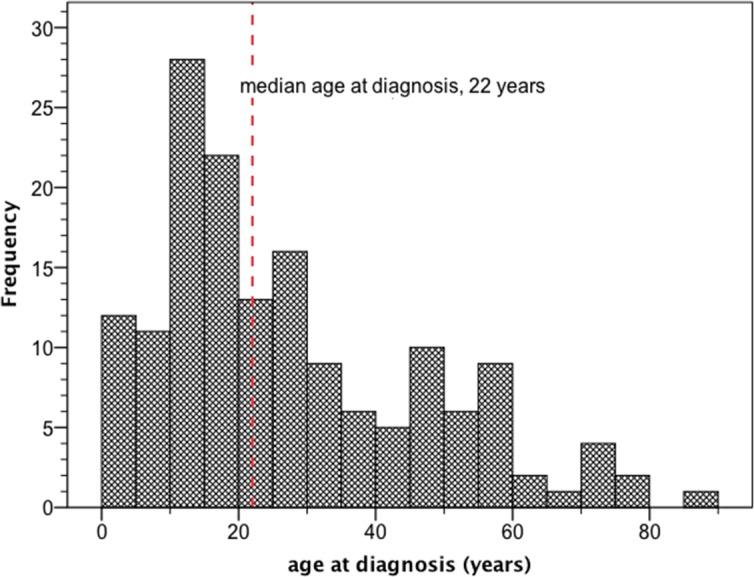
Age distribution of 157 patients with primary spinal origin reported in literature until March 2015.It is displayed in the form of a histogram. Median age at diagnosis was 22 years.